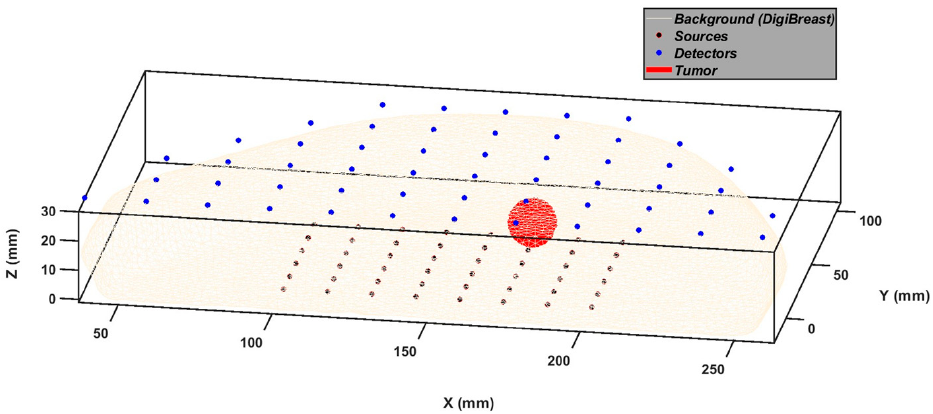
Figure 1. Simulated compressed breast mesh with various components and source–detector geom- etry.